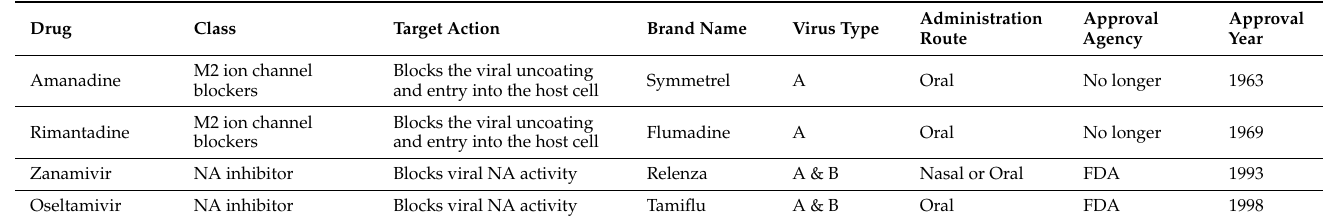
Table 1. Approved classes of antivirals for influenza